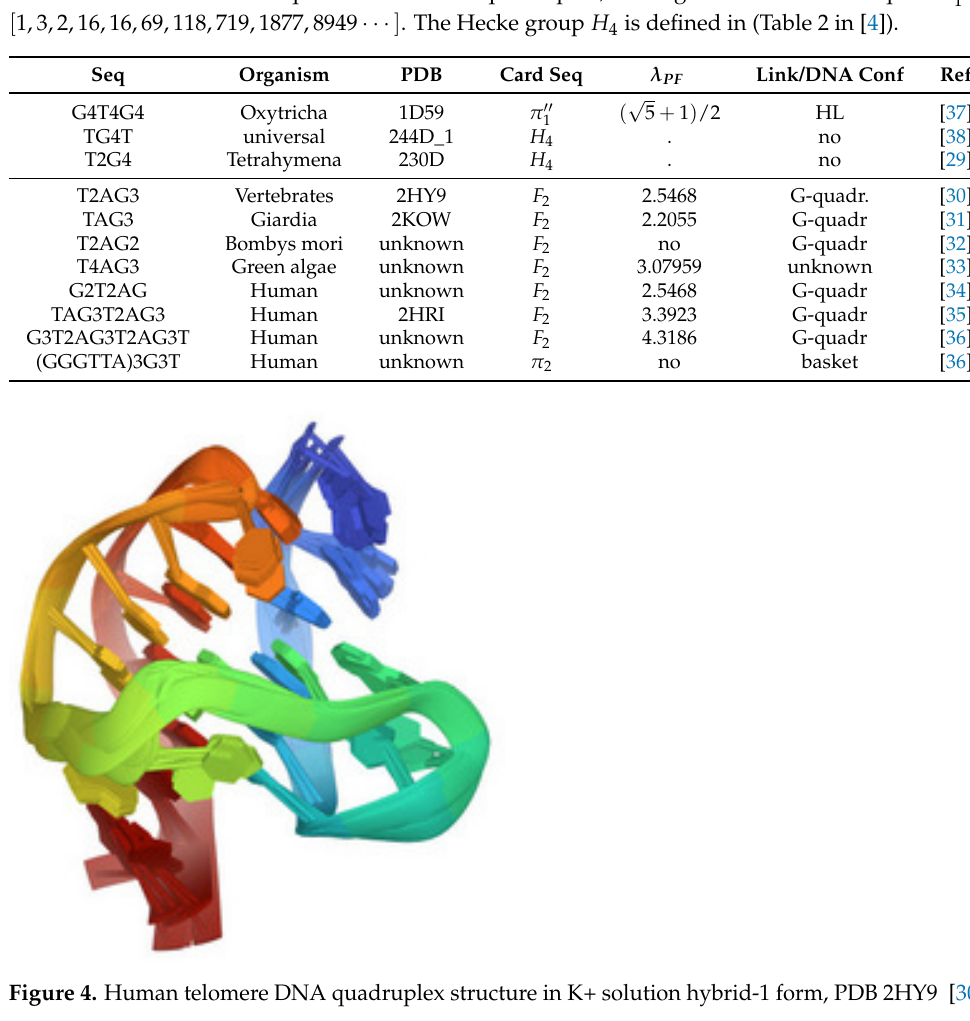
Table 4. Group analysis of the telomere sequence found in some eukaryotes. The first column is for the telomere repeat, the second column is the organism under investigation, the third column is for the PDB code, the fourth column is for the card seq of the group π or that of the corresponding group that is identified, the fifth column is for the Perron–Frobenius eigenvalue when the sequence is found to be aperiodic, the sixth column identifies the presence of the Hopf link (in two-base sequences) or the DNA conformation (in three-base sequences) and the seventh column is a relevant reference. The notation G-quadr is for the G-quadruplex; see Figure 4. The card seq for π (cid:48)(cid:48)